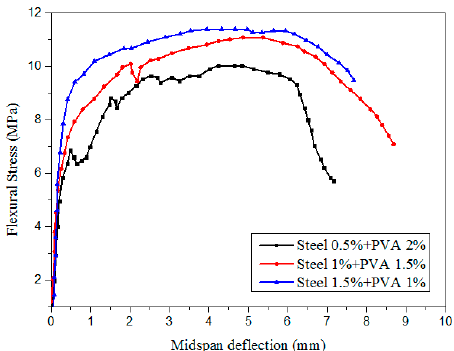
Figure 20. Effects of SFs and PVA fibers on the flexural strength and mid-span deflection of Figure 20. E ff ects of SFs and PVA fibers on the flexural strength and mid-span deflection of cementitious cementitious composites [99]. composites [99].